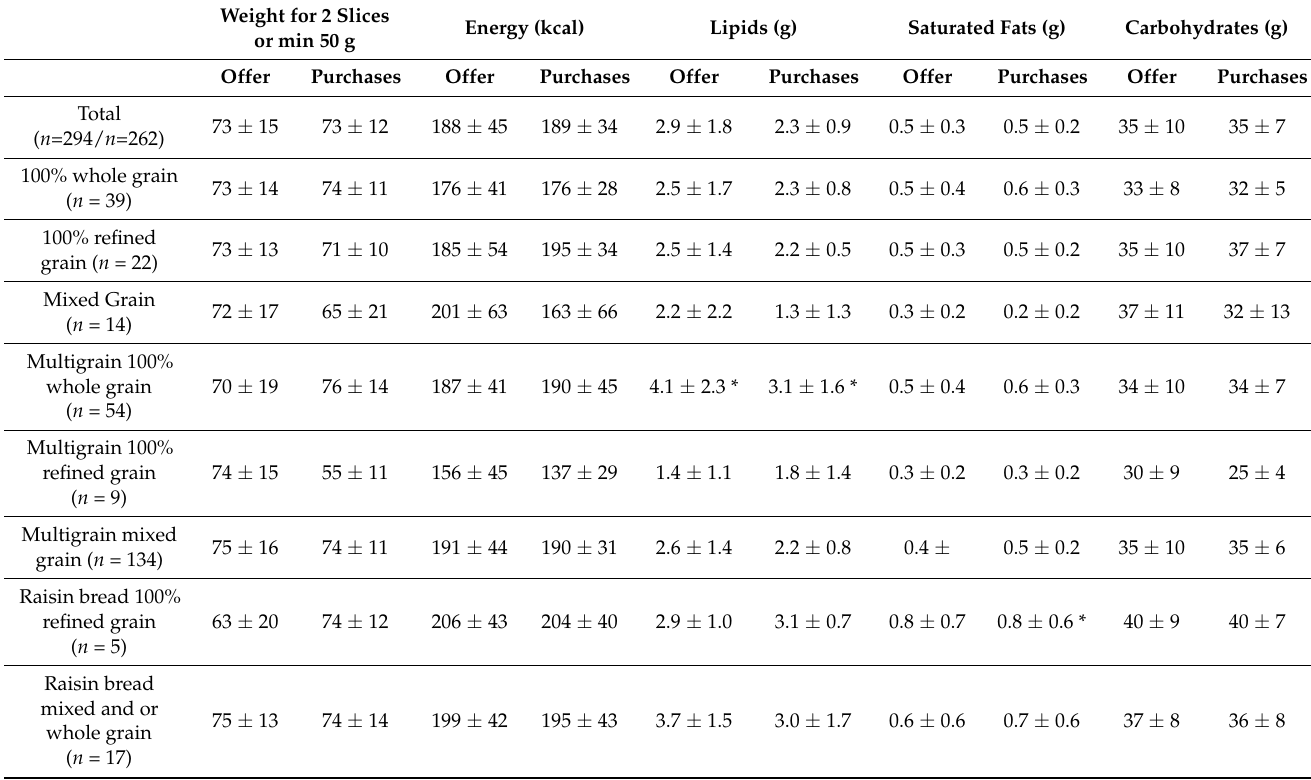
Table 2. Nutritional value and selling price per two-slice portion of sliced bread offered and purchased in Quebec, according to the type of